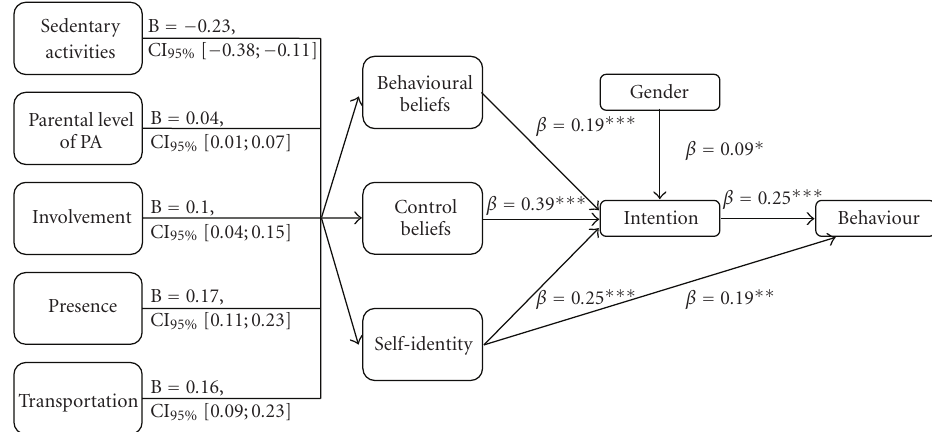
Figure 1: Final model explaining children’s physical activity behaviour and intention. ∗ P < . 05; ∗∗ P < . 01; ∗∗∗ P < . 001, B: Estimates; CI 95% : Bias corrected and accelerated confidence interval; β : Standardised